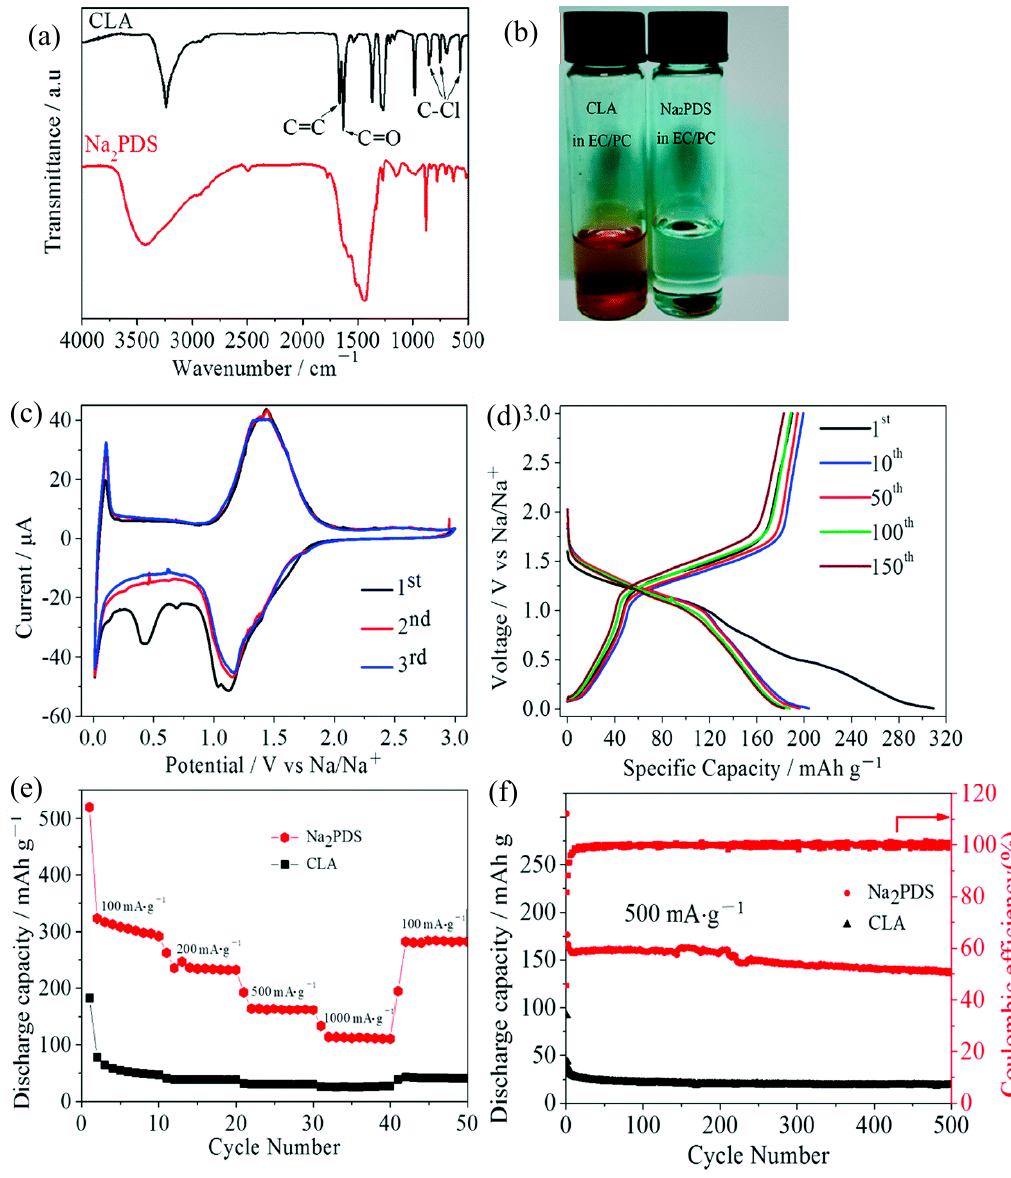
Figure 4. ( a ) Fourier transform infrared spectra of 2,5-dichloro-3,6-dihydroxy- p -quinone (CLA) and sodium salt of poly(2,5-dihydroxy- p -benzoquinonyl sulfide) (Na 2 PDS); ( b ) photograph of the CLA powder and the Na 2 PDS electrode in the electrolyte; ( c ) CV curves of the Na 2 PDS electrode at a scan rate of 0.1 mV · s − 1 ; ( d ) discharge and charge profiles of the Na 2 PDS electrode at a current density of 100 mA · g − 1 ; ( e ) rate performance and ( f ) cycling performance of CLA and Na 2 PDS as candidate anode materials for sodium-ion batteries. Adapted from [50], with permission from © 1996 Royal Society of Chemistry.